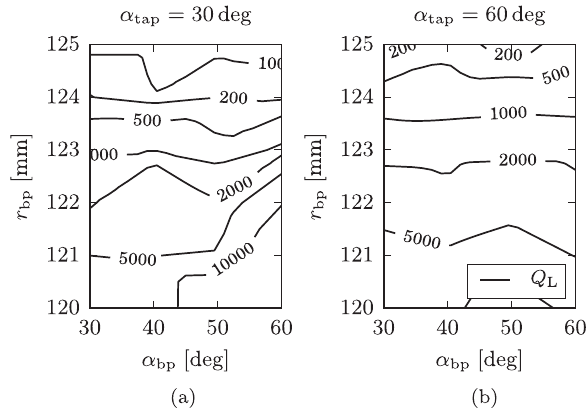
FIG. 16. Q-factor derived from the transverse wakefield for a ¼ 30 mm and a tapering angle design with an iris radius of r ir α of 30 deg (a) or 60 deg (b), respectively. The beam pipe tap radius r varies in a range where the dominating dipole mode bp starts to propagate. The tapering angle α describing the beam bp pipe enhancement is applied on the axis of abscissae.